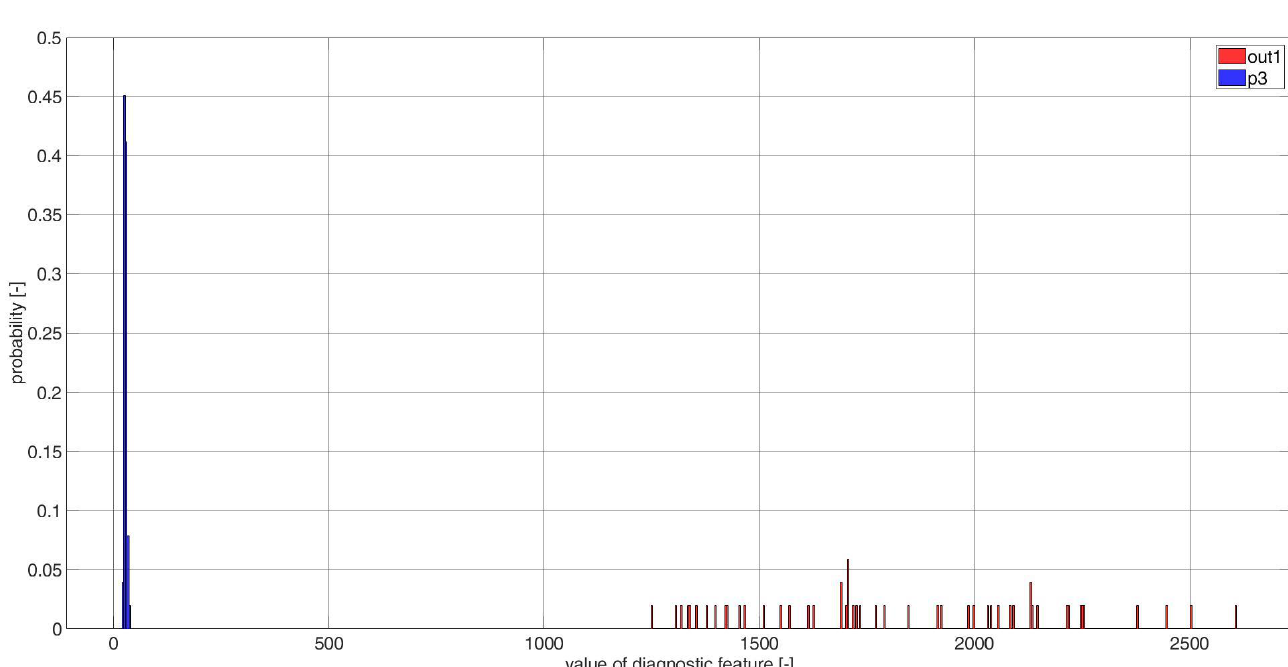
Figure A27. Histogram of diagnostic features based on the CCSM3 (correlation number is 1 — Table A2) bearings out1 and p3.